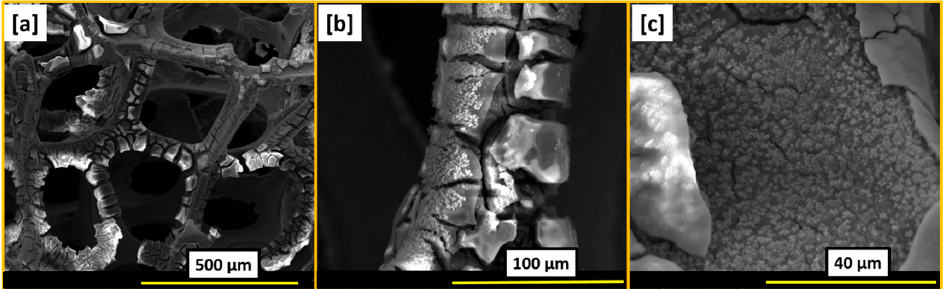
Figure 2. Scanning electron microscopy (SEM) images of electrodeposited CoFe 2 O 4 on Ni-foam.